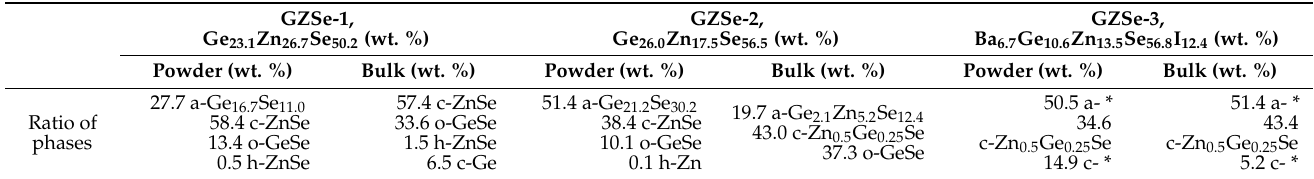
Table 2. The weight percentages of the phases formed in powders and in bulks as inferred from XRD. In the GZSe-3 samples, unidentified amorphous and crystalline phases, denoted with “*”, are present. GZSe-1, Ge 23.1 Zn 26.7 Se 50.2 (wt. %)